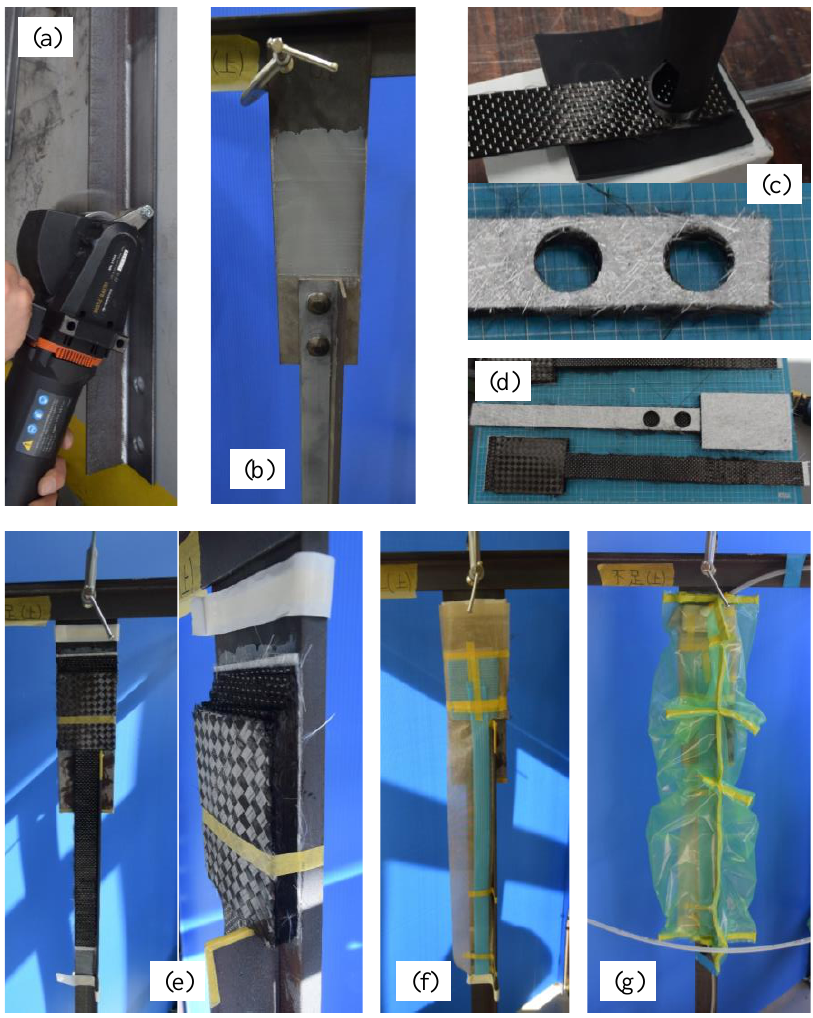
Figure 9. Molding and bonding process: ( a ) surface treatment; ( b ) application of primer resin; ( c ) cutout of carbon fiber cloth; ( d ) pre-formed carbon fiber cloths; ( e ) setup of preformed carbon fiber cloth; ( f ) setup of peel ply and resin flow media; ( g ) setup of bagging film around the specimen for vacuuming and resin injection.